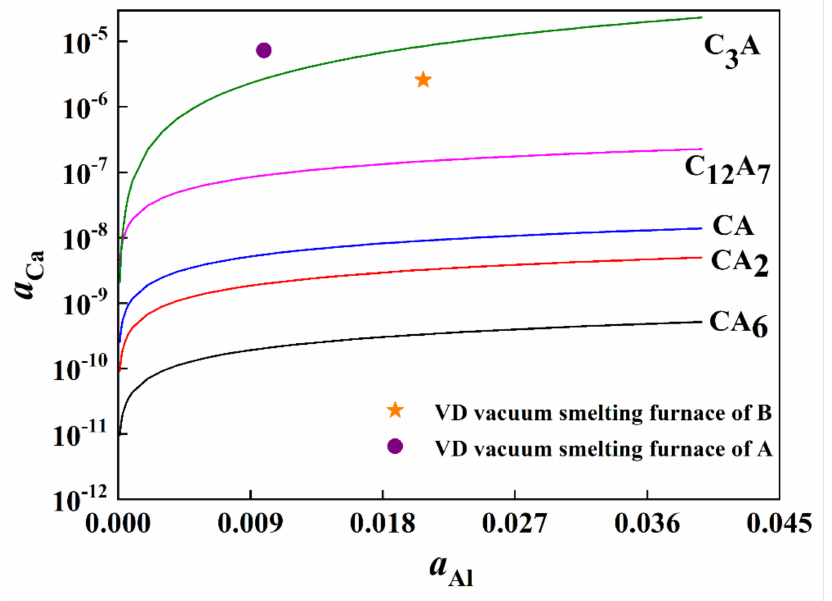
Figure 8. Generating balance diagrams for different calcium-aluminate complex non-metallic